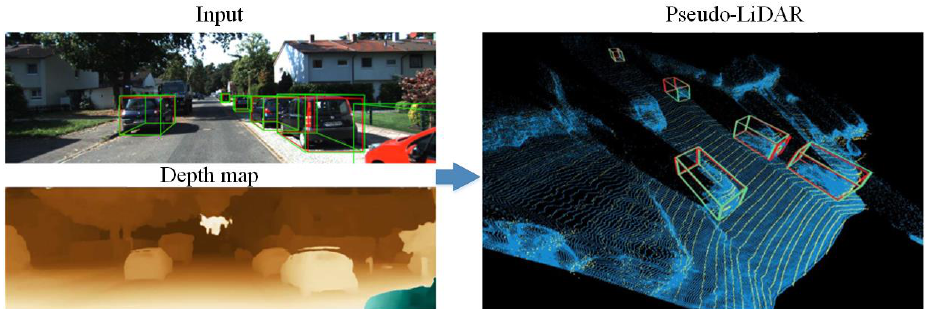
Figure 6. Pseudo-LiDAR point cloud from visual depth